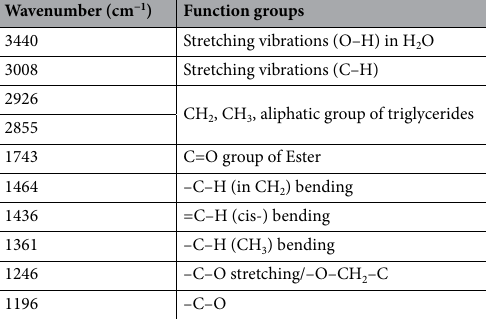
Wavenumber (cm −1 ) Function